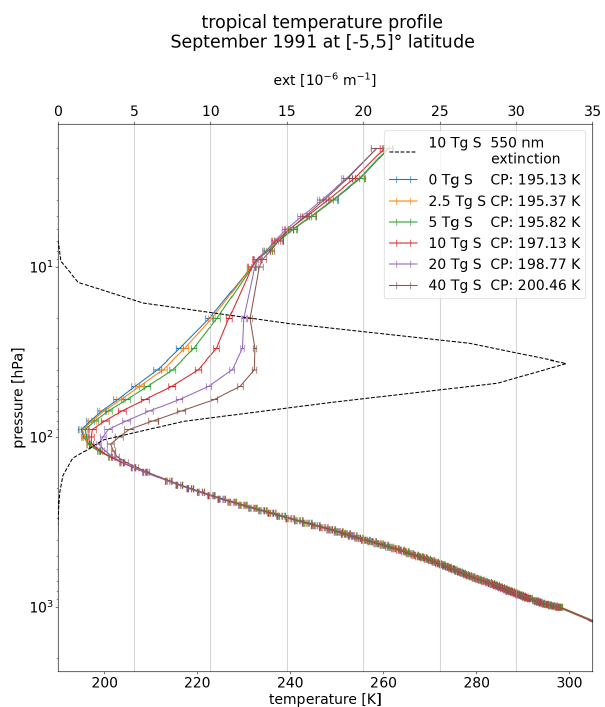
Figure 3. Inner tropical average of the temperature profiles for the five volcanically perturbed EVAens runs (2.5, 5, 10, 20 and 40Tg S) in September 1991 (3 months after the eruption). The temperature of the respective cold point (CP) is indicated in the legend. The solid line represents the ensemble mean; the error bars symbolize the ensemble standard deviations. The 550nm extinction values for the 10Tg S aerosol profile are shown with a dashed black